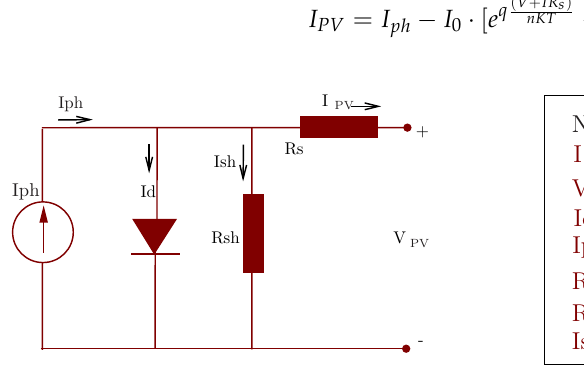
Figure 2. Simplified equivalent circuit of a photovoltaic